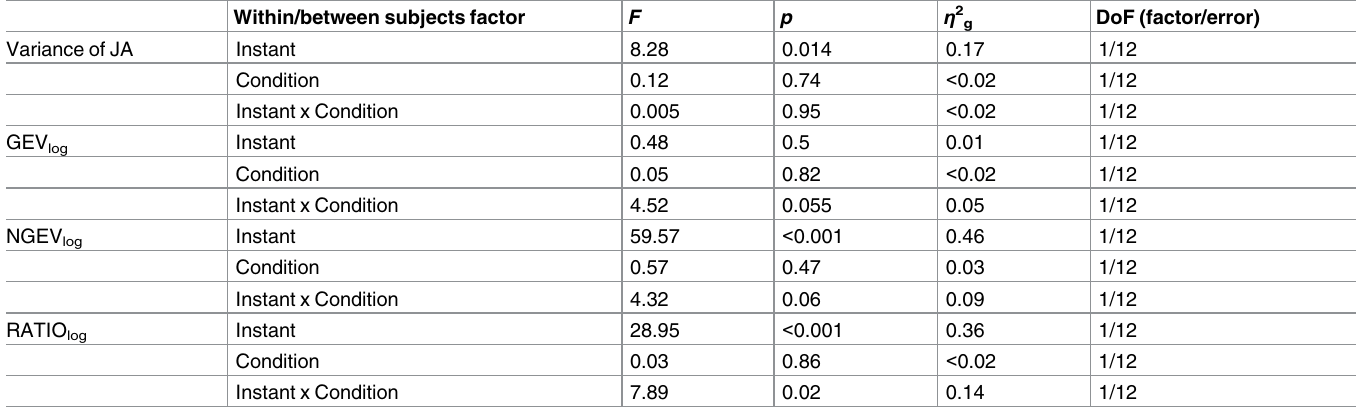
Table 2. Summaryof ANOVA results on varianceof joint angles (JA), GEV log , NGEV log , and RATIO log with factors Instant (at the obstacle and at the end of movement) and Condition (pretest and practice). Within/between subjects